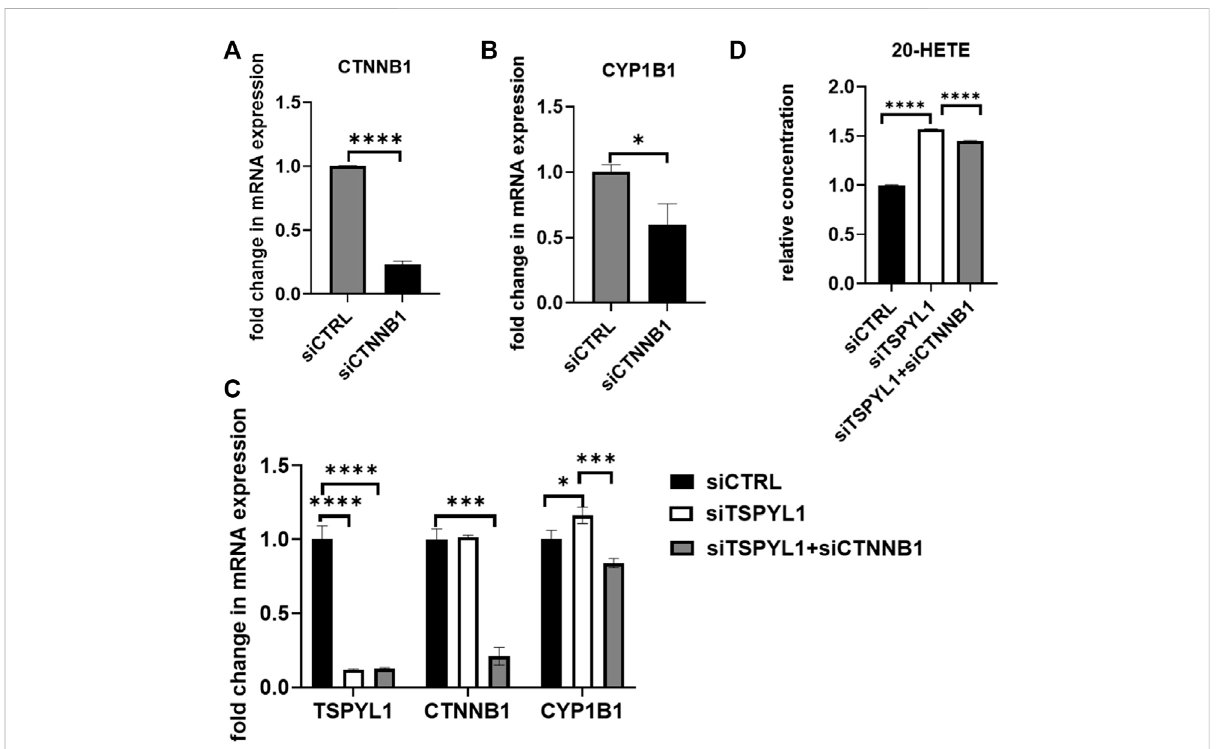
FIGURE 7 β -CateninknockdownrescuesTSPYL1knockdown-relatedincreaseinCYP1B1. (A) HepaRGcellswithorwithout β -catenin(CTNNB1)depletion bysiRNAweretransfectedasindicated. (B) CYP1B1 expressionwastestedbyqRT-PCR. (C) HepaRGcellswithTSPYL1orCTNNB1depletionbysiRNA were transfected as indicated. CYP1B1 expression was tested by qRT-PCR. Gene-speci fi c data were normalized to GAPDH expression. (D)